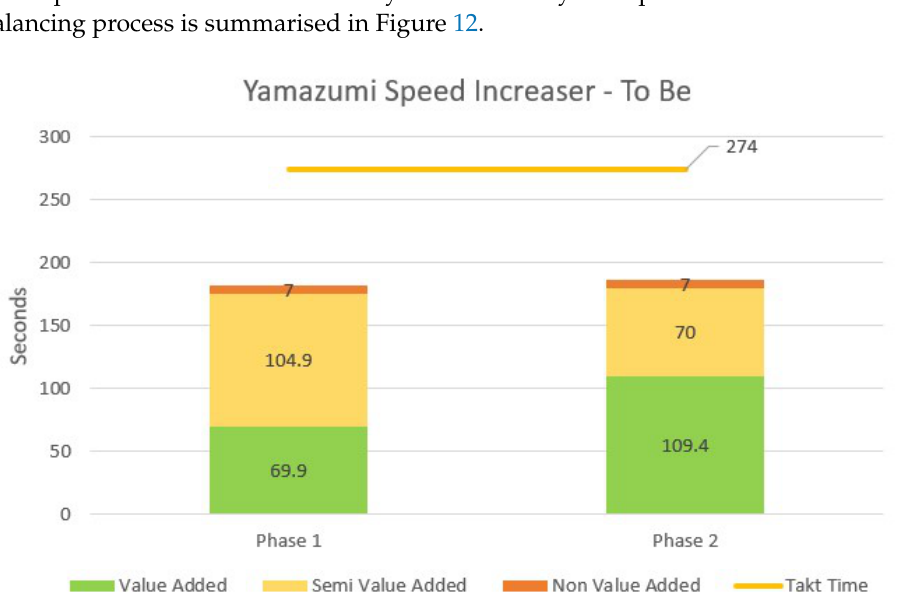
Figure 12. Yamazumi chart for the “to-be” expected state: it is worth noting the result of the operations balancing, in which 7 s have been added for each phase to take into account the steps that the operator must perform to move along the line (estimated at about 1 second per